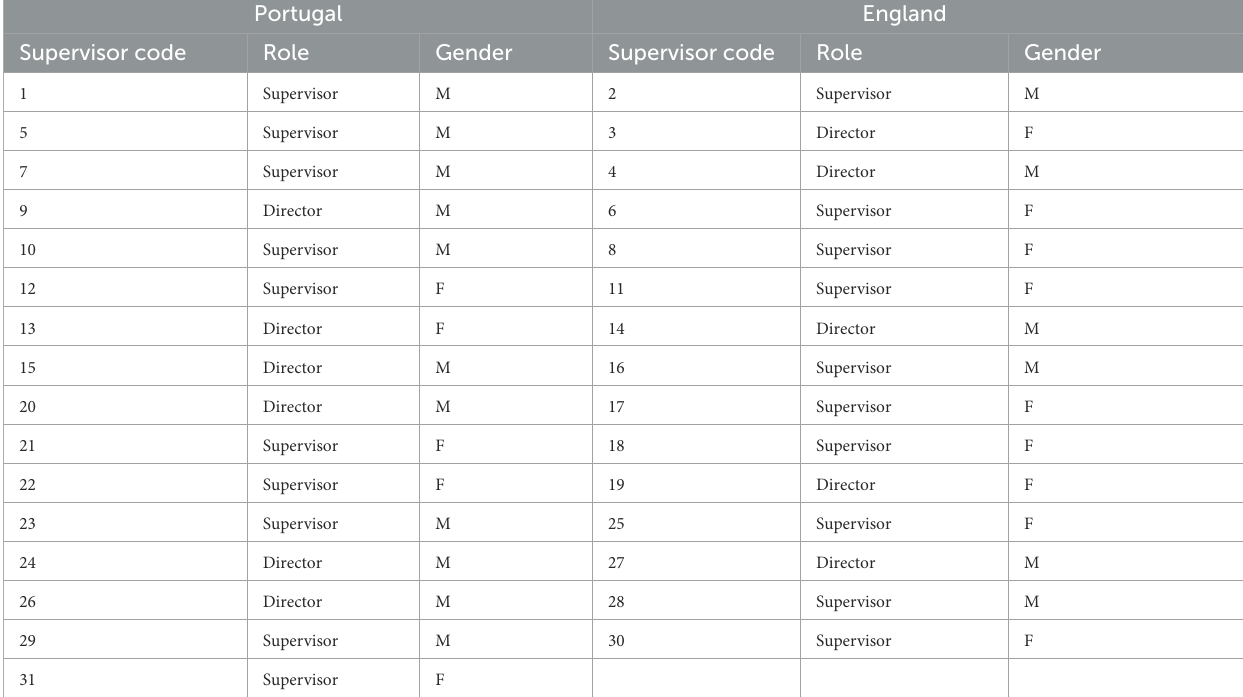
TABLE 1 Description of